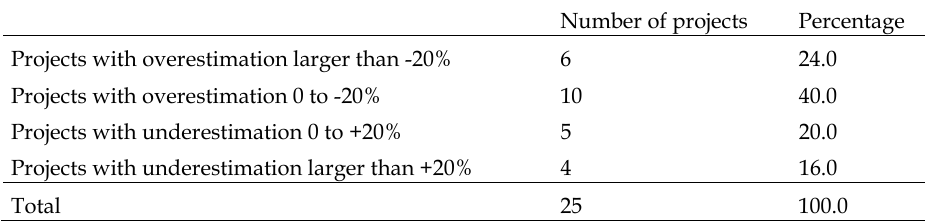
Table 2. Distribution of projects by percentage inaccuracy.